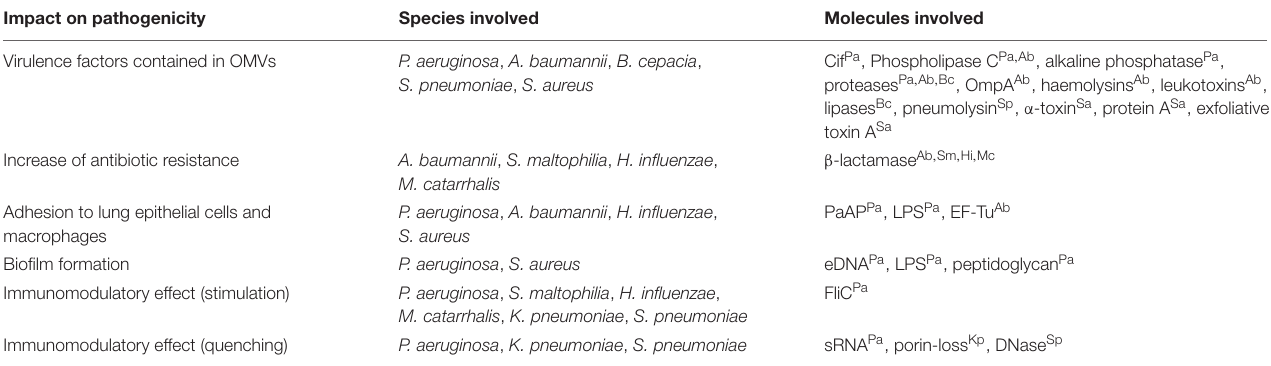
TABLE 1 | Overview of the impact on membrane vesicles produced by species associated with CF and nosocomial pneumonia on pathogenicity, based on factors identified in